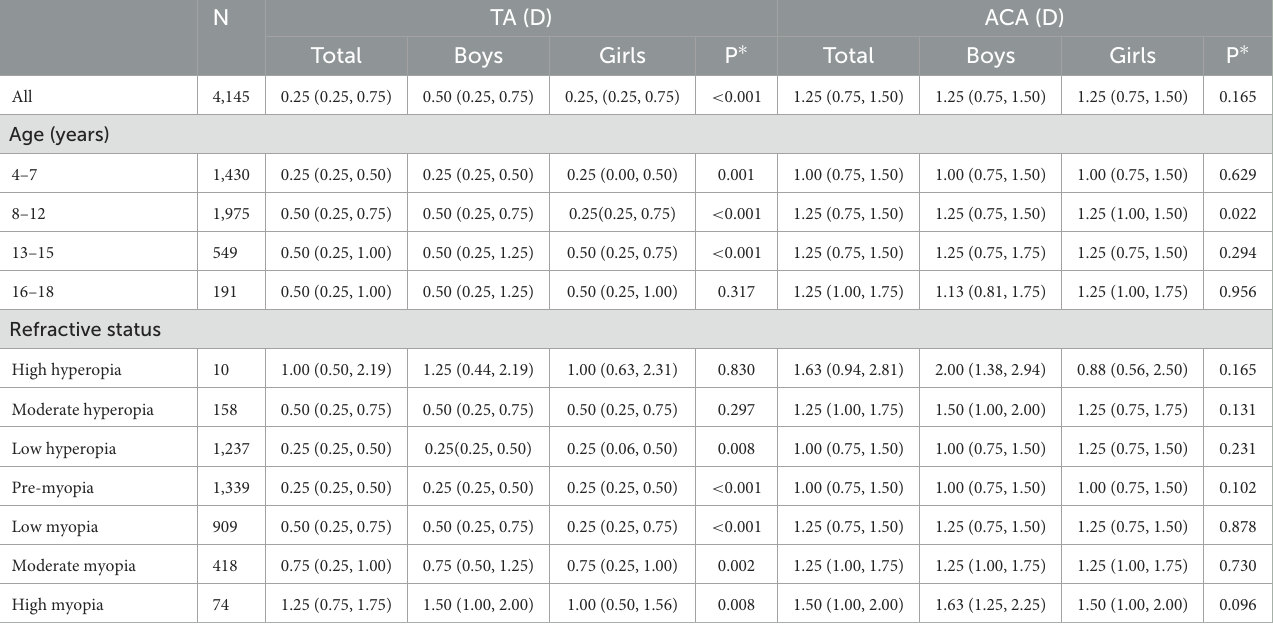
TABLE 1 Age and refractive status related changes in TA and